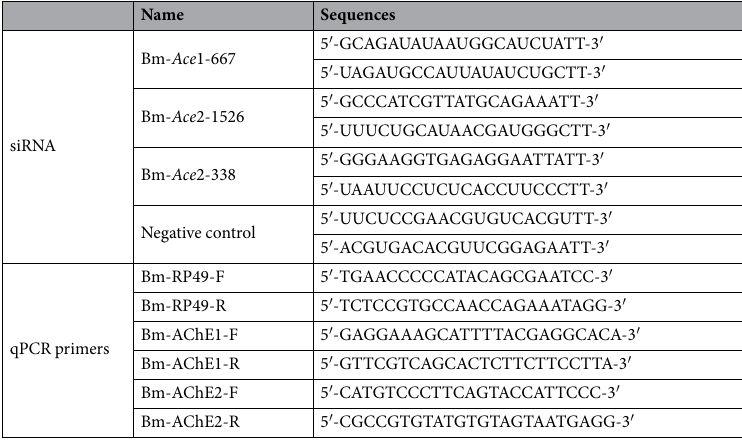
Table 1. The sequences of siRNA for RNA interference and primers for quantitative real-time